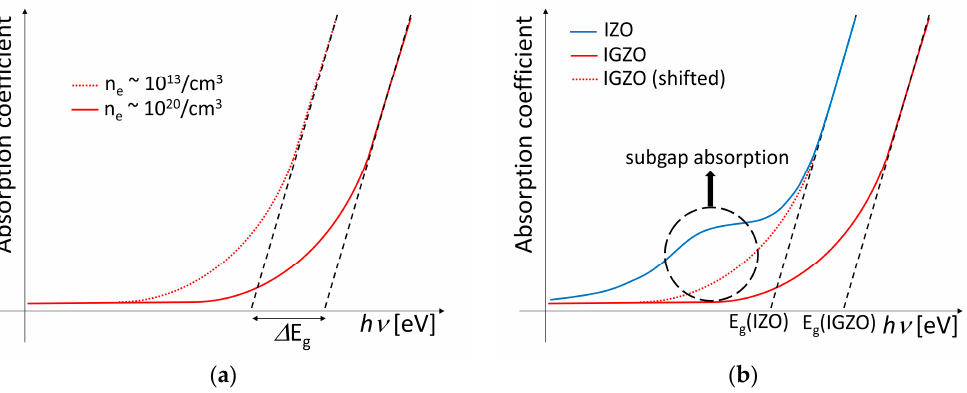
Figure 2. ( a ) Comparative Tauc plot for each carrier concentration (n e ~ 10 13 /cm 3 and n e ~ 10 20 /cm 3 ). ( b ) Conceptual Tauc plots to compare two different cases – large and small (IZO/IGZO) amount of oxygen defects (redrawn and adapted from [6]).